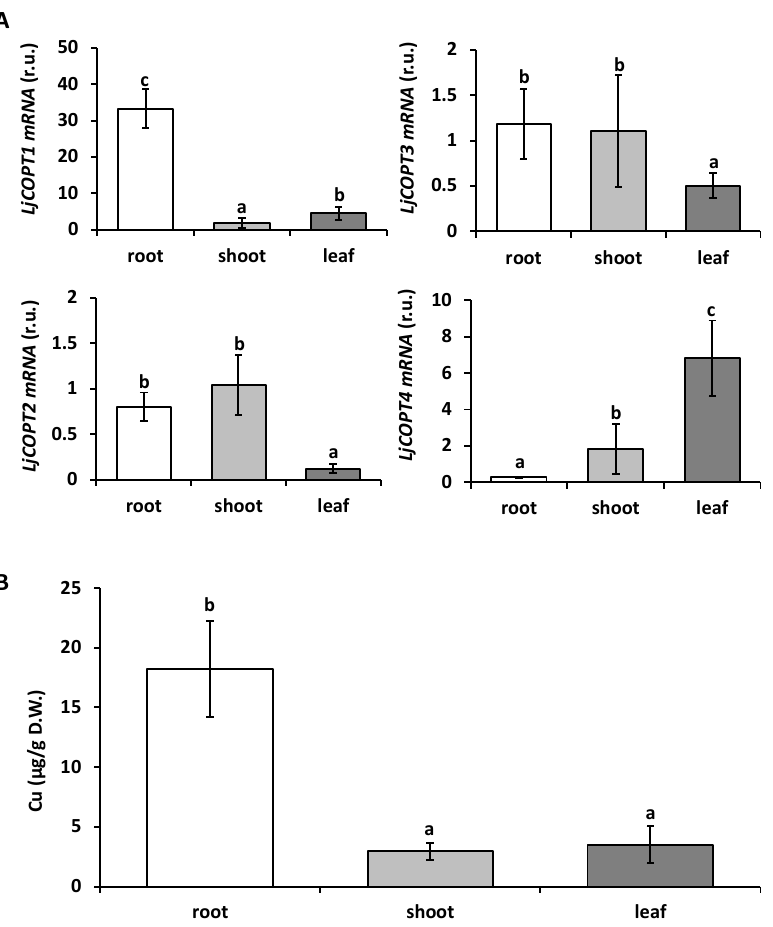
Figure 5. Gene expression and copper content in di ff erent tissues of Lotus japonicus . ( A ) Gene expression of LjCOPT1 , LjCOPT2 , LjCOPT3 , and LjCOPT4 was analyzed by RT-qPCR and normalized to the transcript levels of the Elongation Factor ( EF-1 α ) gene. The stem sample was used as a reference. ( B ) Cu content was measured in root, stem, and leaf samples from L. japonicus . Plants were grown under control conditions as described in Material and Methods. DW: Dry weight. Values are means ± SD of three and six biological replicates, respectively. Di ff erent letters above the bars represent significant di ff erences among all the means ( P < 0.05).